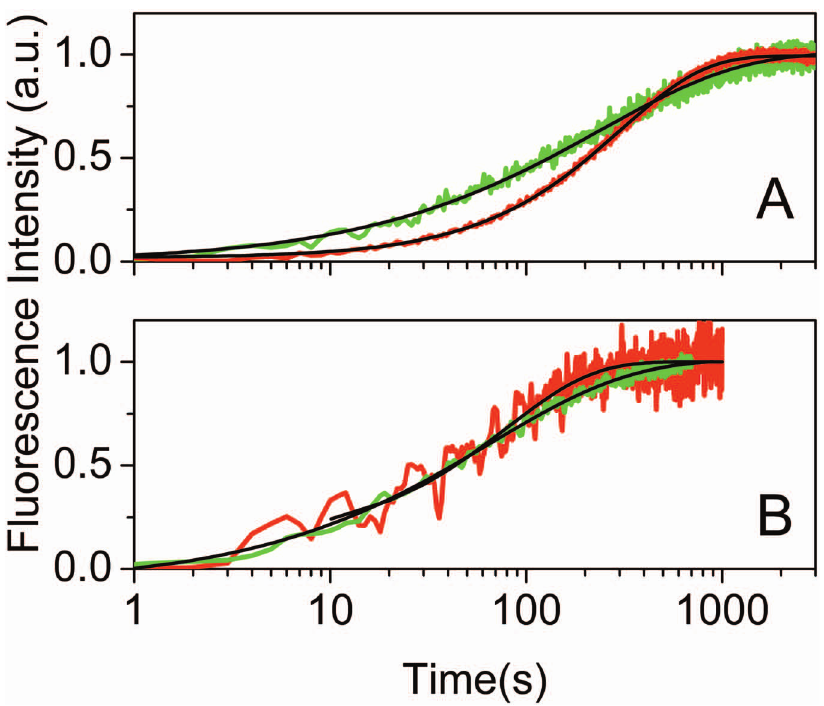
Figure 4. Dark recovery kinetics of E.coli colonies expressing selected YtvA mutants. A. Dark relaxation of YtvAL to YtvAD after 5 minutes illumination with LED465 of E. coli colonies expressing the R63K mutant of YtvA. B. Dark relaxation of YtvAL to YtvAD after 5 minutes illumination with LED465 of E. coli colonies expressing Q123N YtvA. Green curves were measured for colonies smeared on a glass coverslip, red curves were obtained for colonies soaked in an isotonic buffer. Black curves are the best fits to stretched exponential decays. Parameters are reported in Table 1.